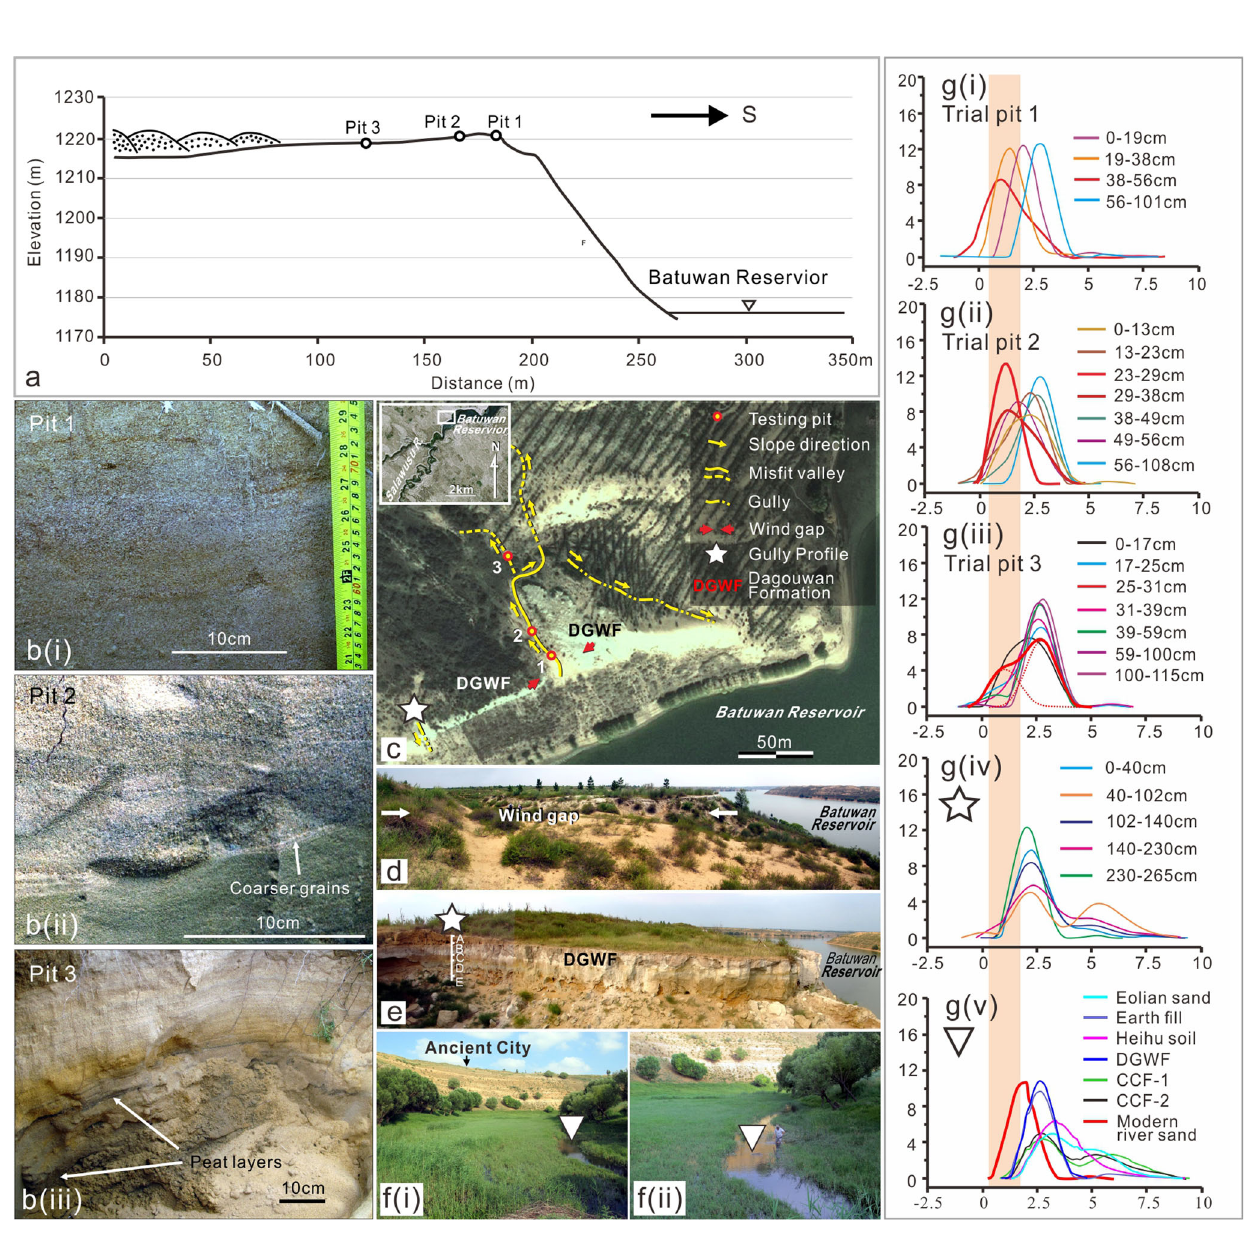
Fig. 4 Results of sedimentary analysis. a Pro fi le of col and mis fi t with 3 trial pits about 1 m deep. b (i) – (iii) Vertical pro fi les of the 3 trial pits, each containing a layer of coarser grained sand (medium-sized sand, refer to grain size distributions in g1-g3). c The slope directions of col and mis fi t, and a gully (marked with a white star) next to col shown in Google Earth satellite image. d Field photograph of the col valley that slopes inland. e Field photograph of the gully, sloping towards the reservoir, with its stratigraphic pro fi le. The gully is marked with a white star in the Google image and has the same strata as the col and mis fi t. f Field photograph of a modern river below the ancient city. The white triangle marks the sampling point. g The grain size distribution of the samples taken from the study area: g (i) – (iii) the grain size distribution of the samples taken at different depths from the 3 trial pits. The grain size of coarse sand in each pit is indicated by the vertical red-orange band or red distribution curves in the plots; ( g ) (iv) the grain size distribution of samples taken from different layers of the stratigraphic pro fi le of the gully (marked with a white star in Fig. 4c and 4e) next to the col and mis fi t; ( g ) (v) the grain size distribution of sedimentary samples taken from the strata of the ancient city (see Fig. 1b) and the modern river below the city (marked with a white triangle in Fig. 4f). Google Earth Maps data: Image @2022 CNES/Image @2022 Maxar